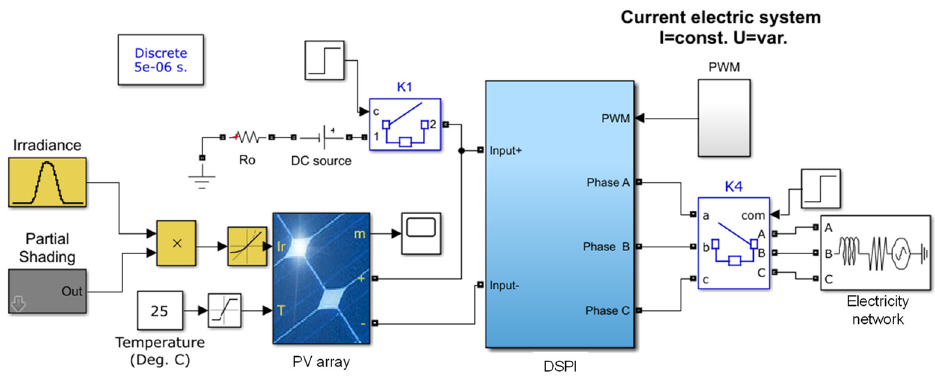
Figure 2. The digital twin of the DSPI developed in the MATLAB Simulink environment.